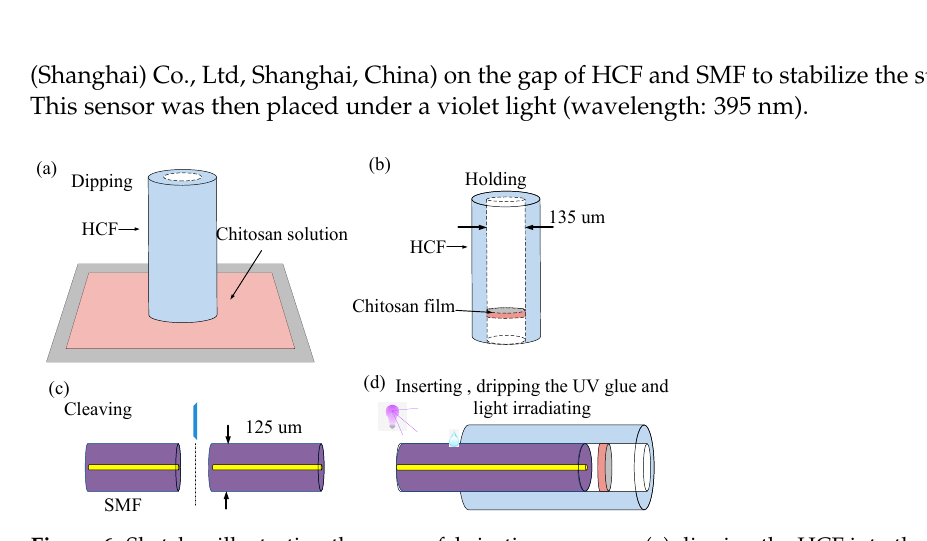
Figure 6. Sketches illustrating the sensor fabrication process—( a ) dipping the HCF into the chitosan solution; ( b ) holding the HCF to form a thin chitosan film; ( c ) cleaving the SMF; and ( d ) inserting the SMF into the HCF, dripping the UV glue and curing under violet light irradiation.